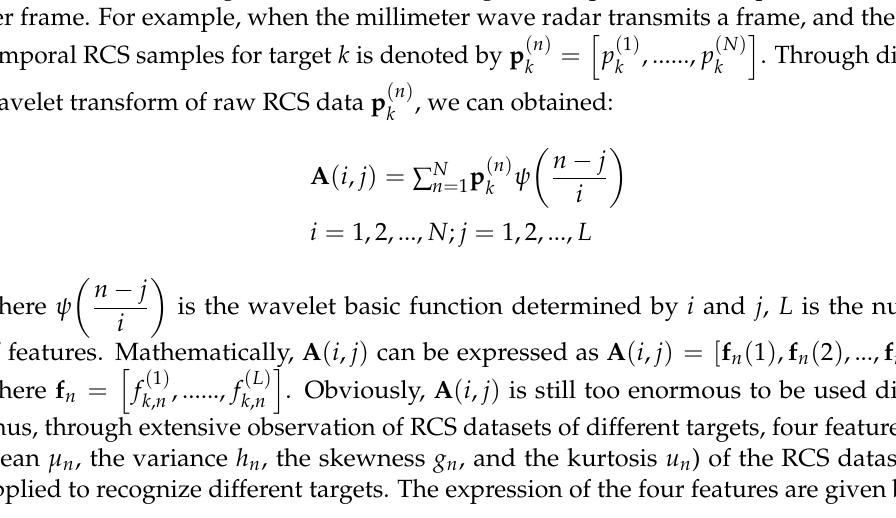
Figure 2. A large number of RCS measurement raw data collected in the experimental environment. Set the chirp time of the millimeter wave radar to 1 µs, and a frame contains 600 chirps, N = 600. For each target, a dataset containing 600 temporal RCS samples is obtained